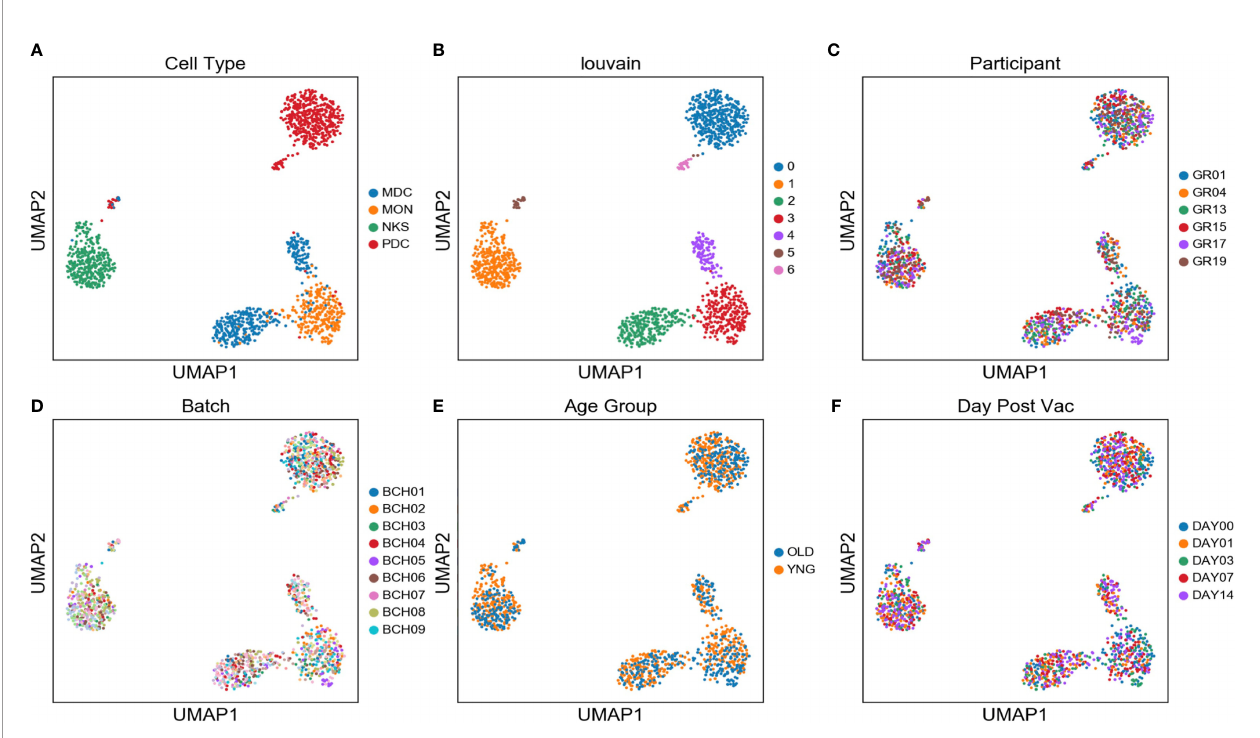
FIGURE 2 | Two distinct mDC subsets are found in blood of participants using scRNAseq - UMAP embedding of single cell transcriptional pro fi les and Louvain clustering results (A – F) reveal seven expression clusters from the four sorted innate immune cell populations, including two distinct mDC clusters (Louvain Cluster #2 and #4). Coloring corresponds to FACS-sorted cell type (A) , Louvain cluster membership (B) , Participant ID (C) , sample processing batch (D) , age group (E) , and sample collection day before or after vaccination (F)